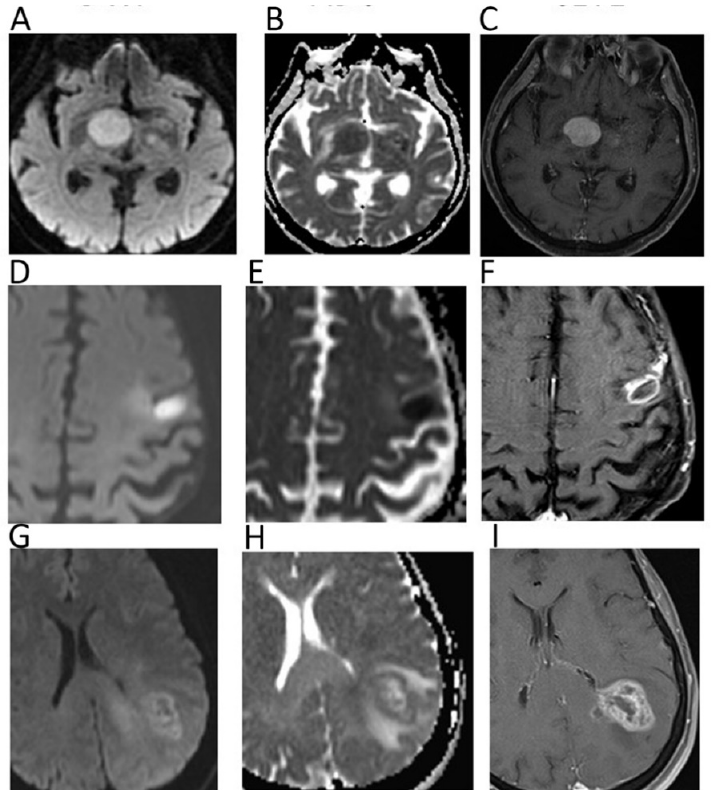
Figure 1. Diffusion weighted imaging (DWI) b = 1000 images ( A , D , G ), corresponding apparent diffusion coefficient (ADC) maps ( B , E , H ), and contrast–enhanced T1 w images ( C , F , I ) of patients with histologically proven primary central nervous system lymphoma ( A – C ), cerebral abscess ( D – F ), and glioblastoma ( G – I ). Mean ADC values in lymphoma (0.648 × 10 − 3 mm 2 / s) and in the central portion of the abscess (0.510 × 10 − 3 mm 2 / s) were lower than in glioblastoma. In particular, mean ADC values were higher in the necrotic core of the GBM (1.082 × 10 − 3 mm 2 / s) in comparison to the abscess.